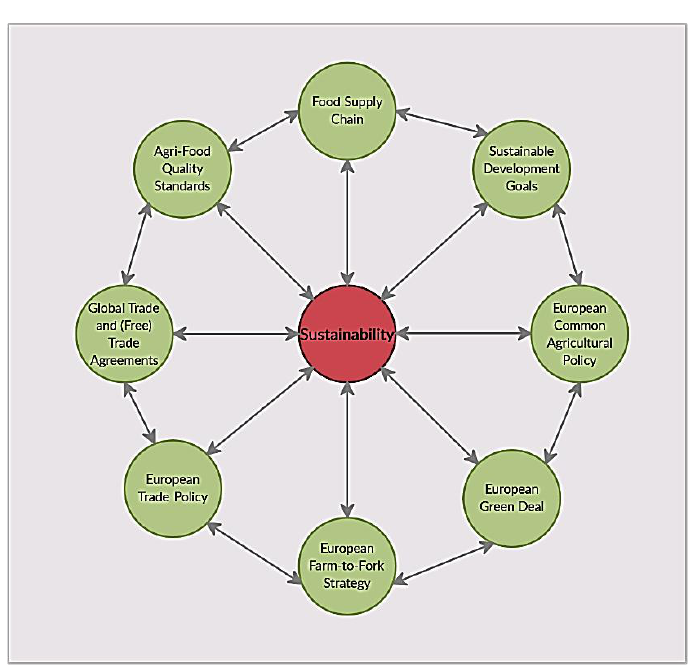
Figure A1. Relationships among the theoretical topics. Source: own illustration.